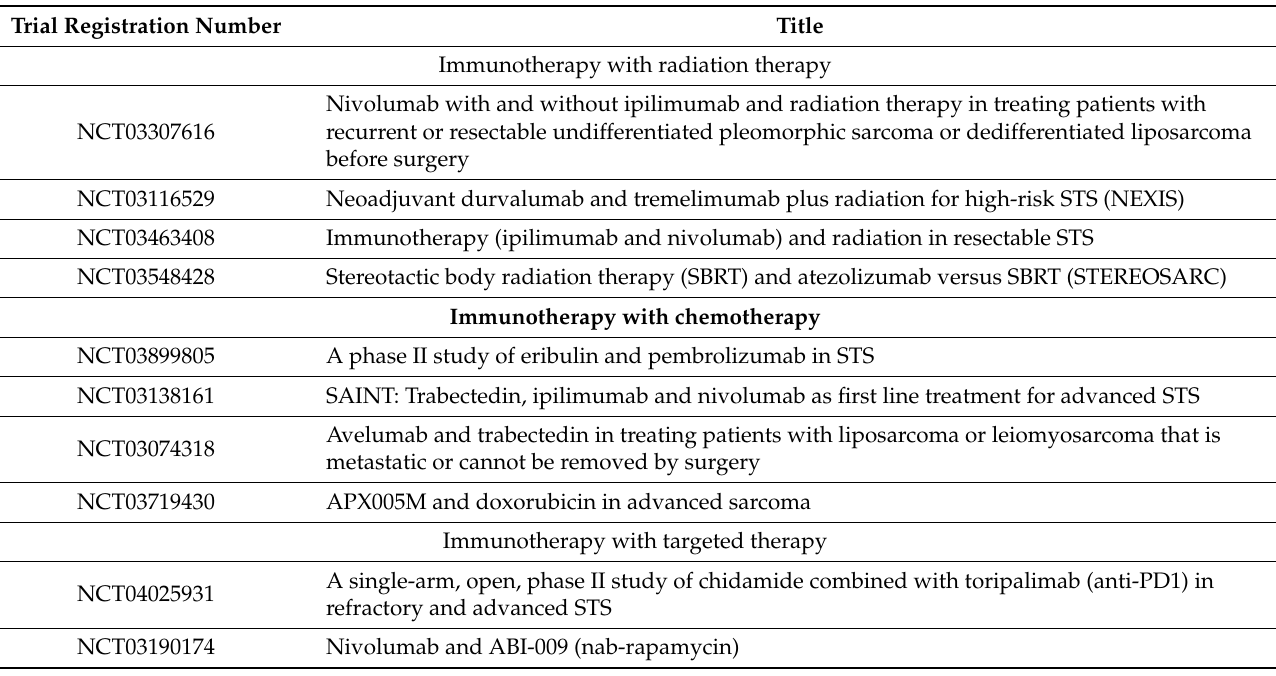
Table 2. Recruiting clinical trials combining immunotherapies with other treatment modalities (https://clinicaltrials.gov) * in adult patients (>18 years of age) with